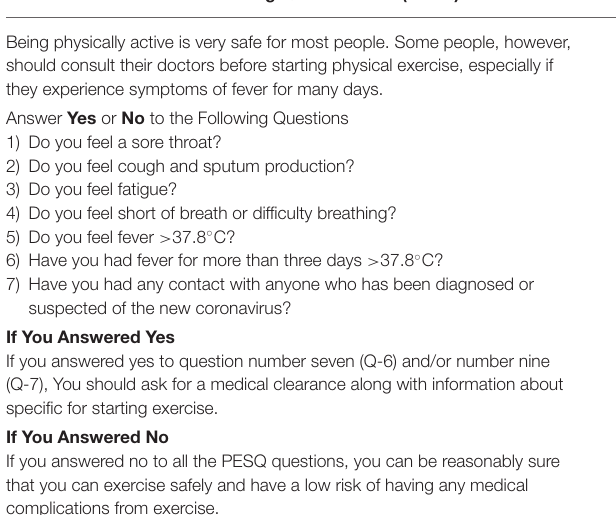
TABLE 1 | Pre-Exercise Screening Questionnaire (PESQ). Take the Pre-Exercise Screening Questionnaire (PESQ) Being physically active is very safe for most people. Some people, however, should consult their doctors before starting physical exercise, especially if they experience symptoms of fever for many